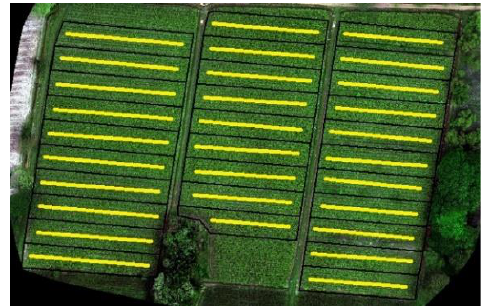
Figure 3. Selection of central grooves in each plot The spectral signature corresponds to an average of 5 measurements of the same leaf. Before starting the variation (Suarez, Apan & Werth,